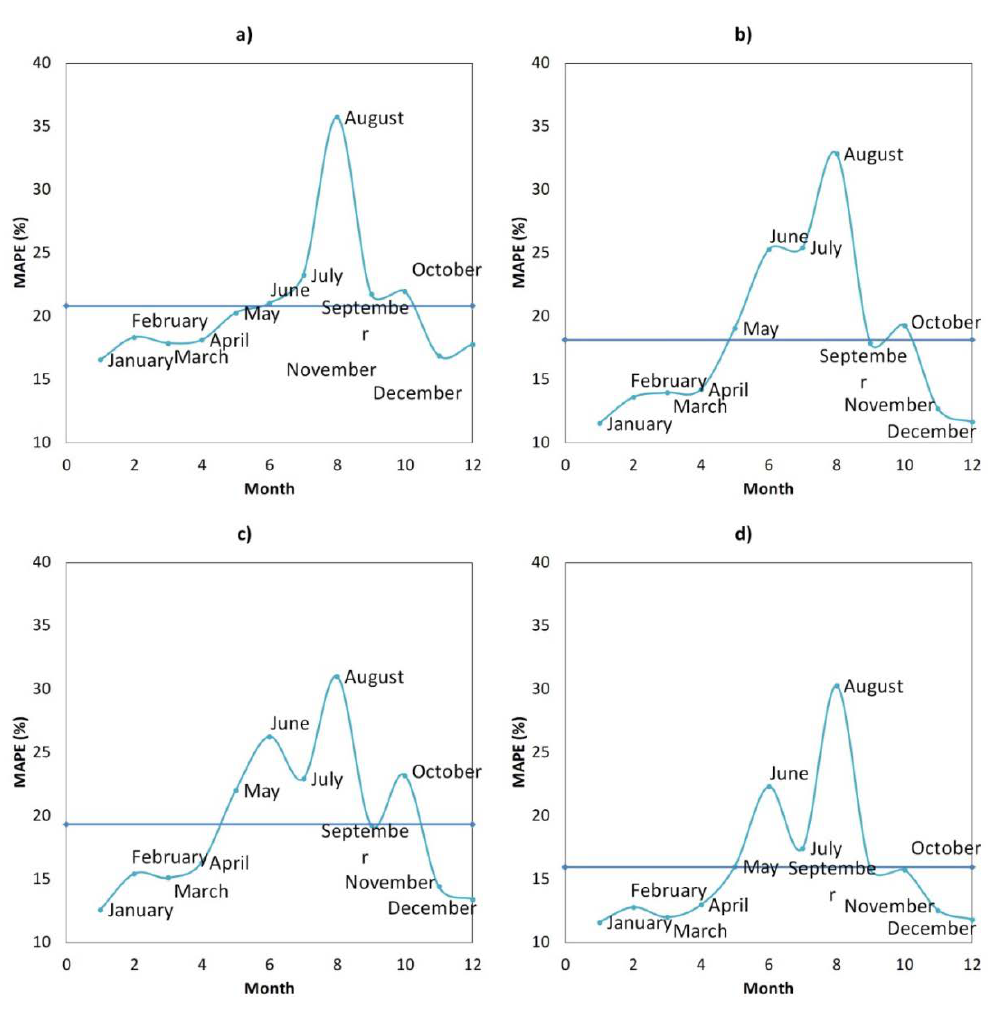
Figure 11. Monthly Average MAPE (%) (6) of the winning architecture (the dark blue line represents the Average MAPE ): ( a ) F_L ; ( b ) F_L_W ; ( c ) F_L_W_DW ; ( d ) F_L_W_M